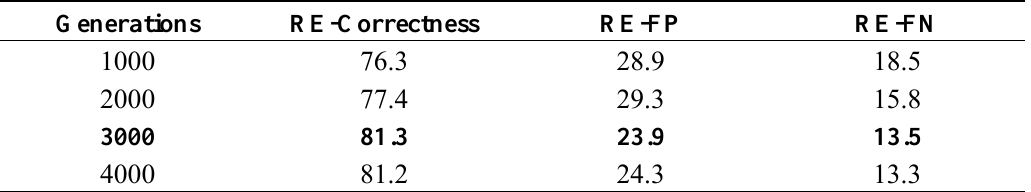
Table 5. Experimental results of integrated classifier (%).